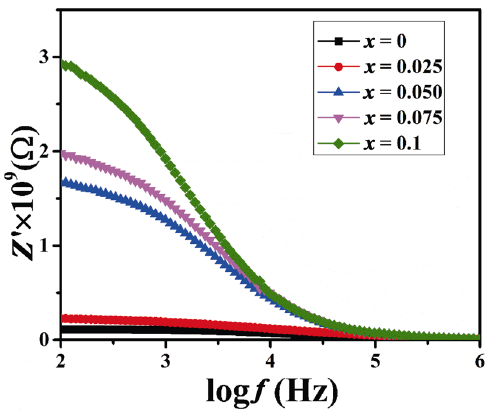
Fig. 11 Variation of real part of impedance of Mn 0.5 Zn 0.5 Gd x Fe 2– x O 4 ( x = 0, 0.025, 0.050, 0.075, and 0.10) with frequency.